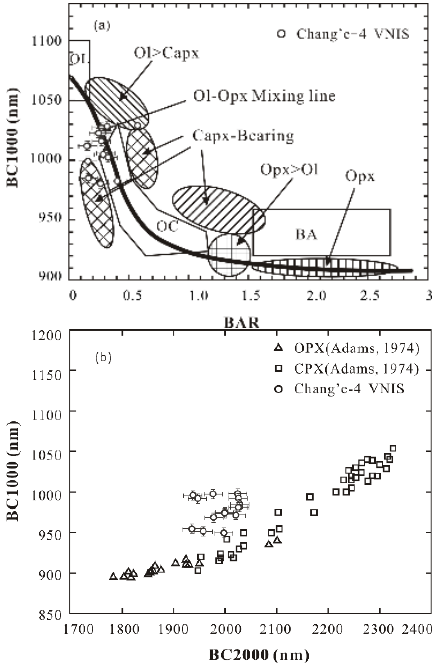
Figure 6. Scatter plots of spectral parameters: (a) BAR - BC1000; (b) BC2000 - BC1000. BAR: Band area ratio. BC1000: